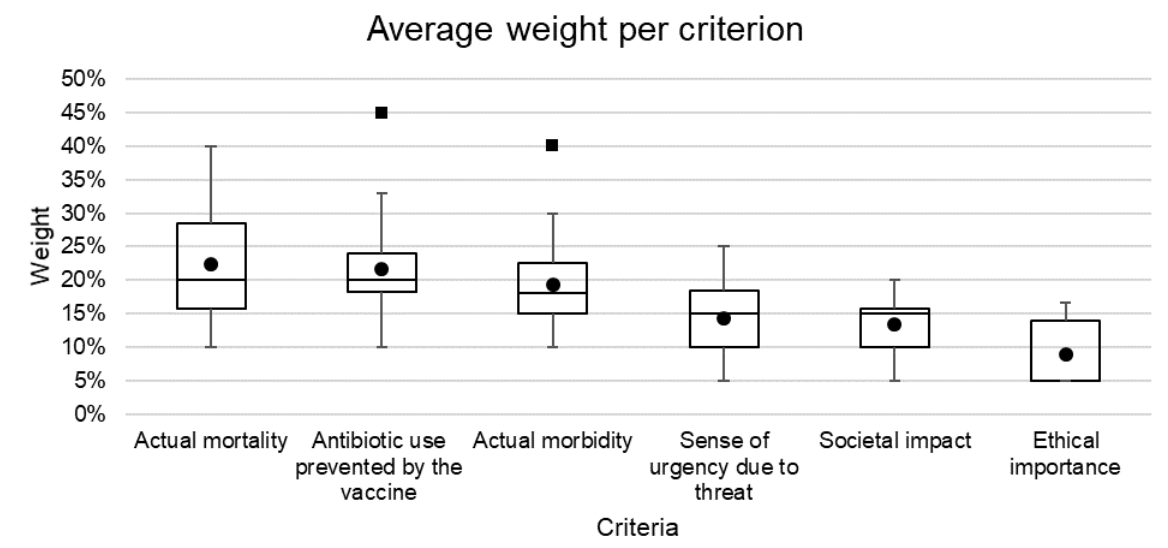
Figure 1. The weighting assigned to each criterion by experts against which vaccine candidates were assessed. Lower error bar= minimum value; lower bound of the box= lower quartile range; black line inside the box=median; upper bound of the box=upper quartile range; upper error bar= maximum value; circle=mean; square = outlier (defined as over 1.5*interquartile range from the 1 st or 3 rd quartile).